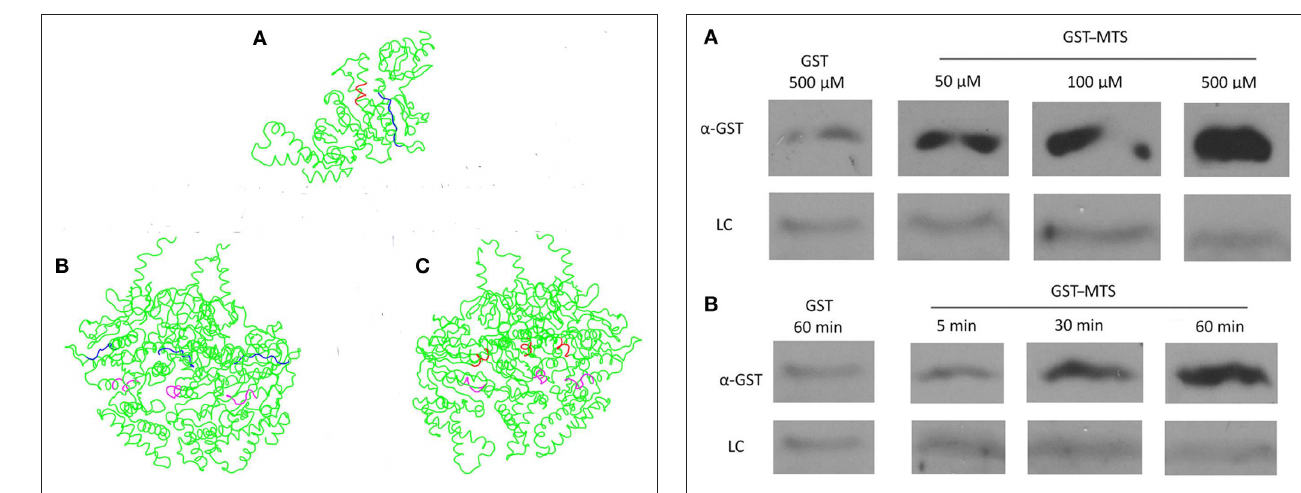
FIgure 5 | uptake of a gST-Membrane transport signal (MTS) fusion protein into eBs. EBs were purified on a discontinuous gastrografin gradient and collected by centrifugation to ensure the use of a homogenous EB mixture. The GST alone and GST–MTS protein was expressed in Escherichia coli cells and purified using glutathione beads. The EBs were then incubated with either GST or GST–MTS, trypsinized for 30 min to ensure that all extracellular GST or GST–MTS was degraded, and examined by α -GST Western blot for the presence of intracellular GST-tagged protein. CdsL, an intracellular type III secretion protein, was used as a loading control (LC). (A) Time-course for incubation of EBs with GST–MTS for 5, 30, or 60 min. GST control at 60 min displayed very little protein while GST–MTS at 5, 30, and 60 min had increasing amounts of GST–MTS present within the EBs. (B) Dose–response of EBs incubated with GST–MTS at 50, 100, and 500 μm. GST control at 500 μm displayed very little protein while GST–MTS accumulated within the EBs as the concentration increased. CdsL is shown as a LC.